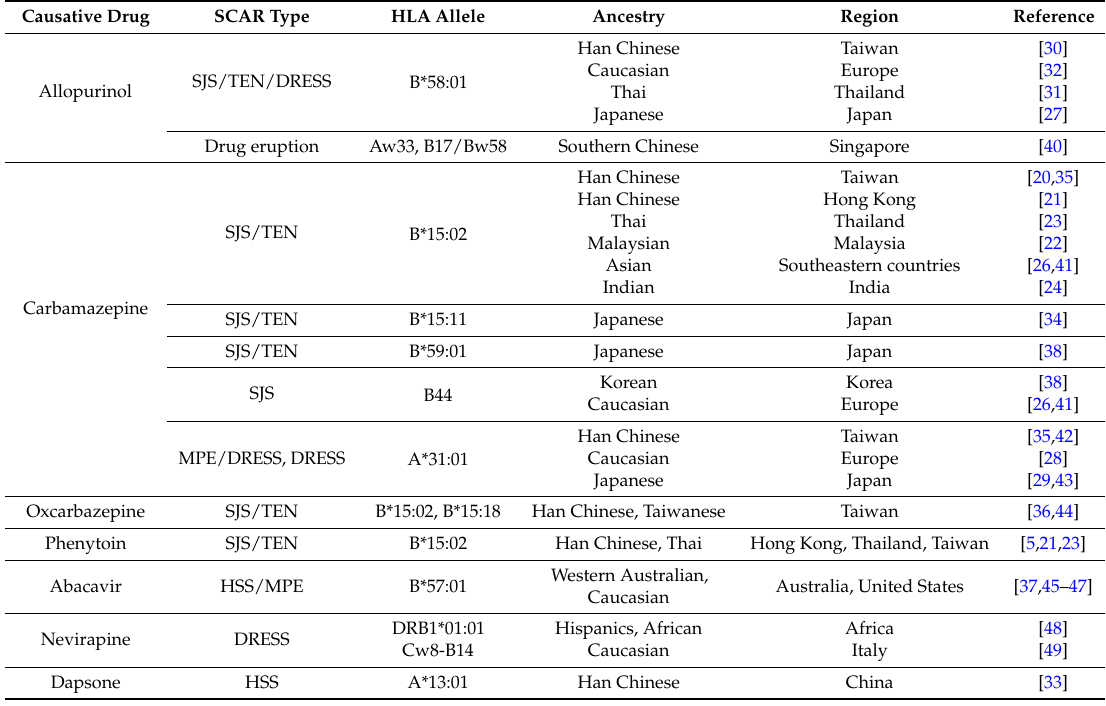
Table 1. Ethnicity- and phenotype-specific associations of human leukocyte antigens (HLAs) with severe cutaneous adverse reactions